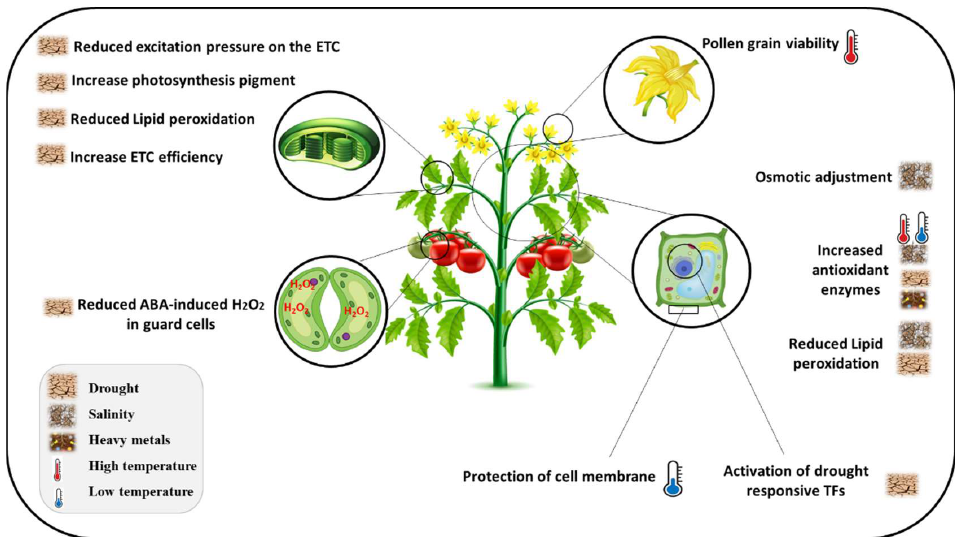
Figure 4. The role of flavonoids in abiotic stress response in plants. Modulation of excitation pressure, increase in photosynthesis pigments, reduced lipid peroxidation in the thylakoid membrane, enhancement of osmotic adjustment, reduction of ABA-induced ROS in guard cells, and activation of stress-responsive transcription factors under osmotic stress. Improving pollen grain viability under high temperature and protection of cell viability under cold temperature.